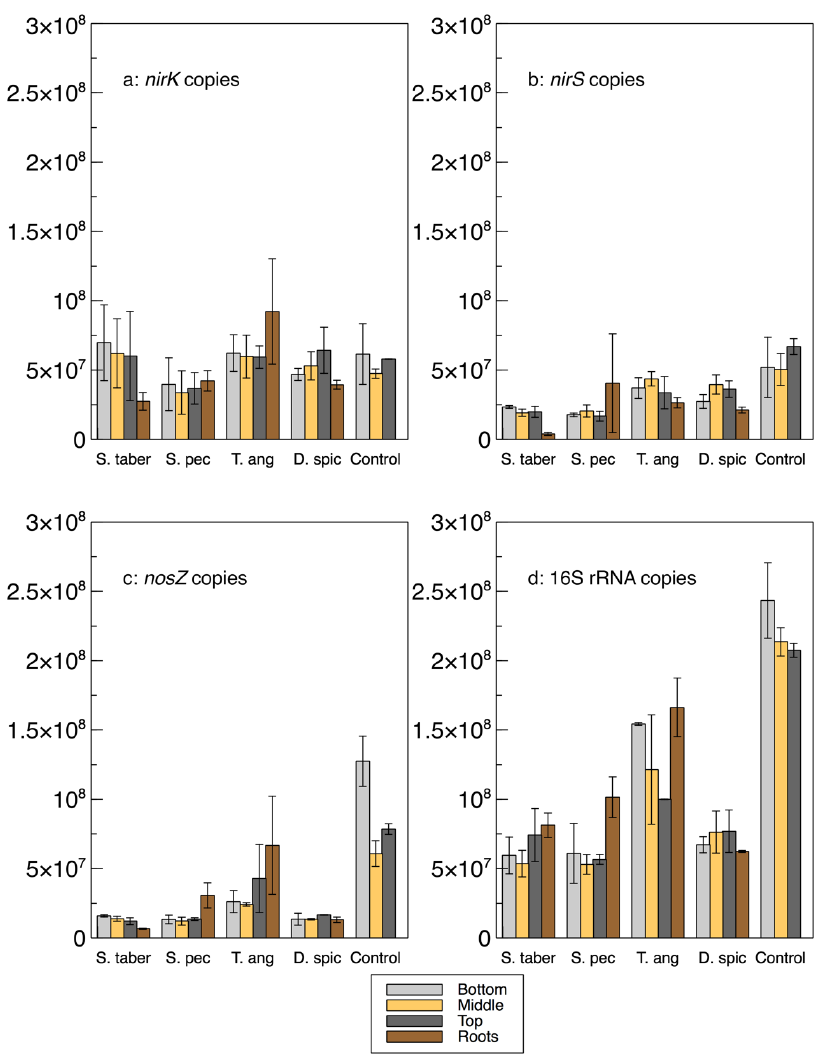
Figure 3. Gene copy numbers (a: nirK , b: nirS , c: nosZ and d: 16S rRNA) in the extracted biofilm from the bioreactors’ media at 3 depths and in plant roots. Error bars: standard deviations. Table 2. Functional denitrifying gene parameters ± (SD) in the biofilm from the wood-chip samples (average of 3 depths), as well as the root samples.